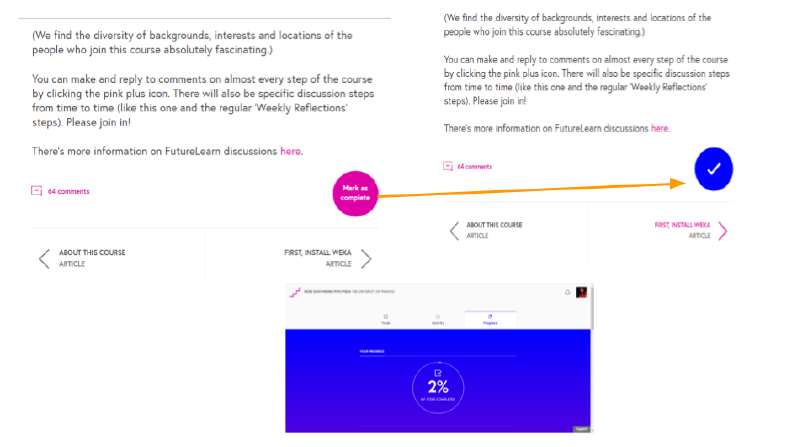
Fig. 1. Future Learn platform offers manual update on the course